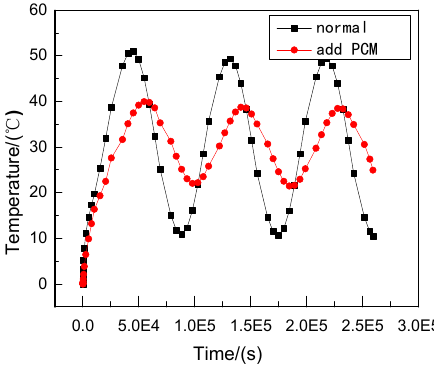
Figure 15. Transient heat transfer temperature characteristic curve.